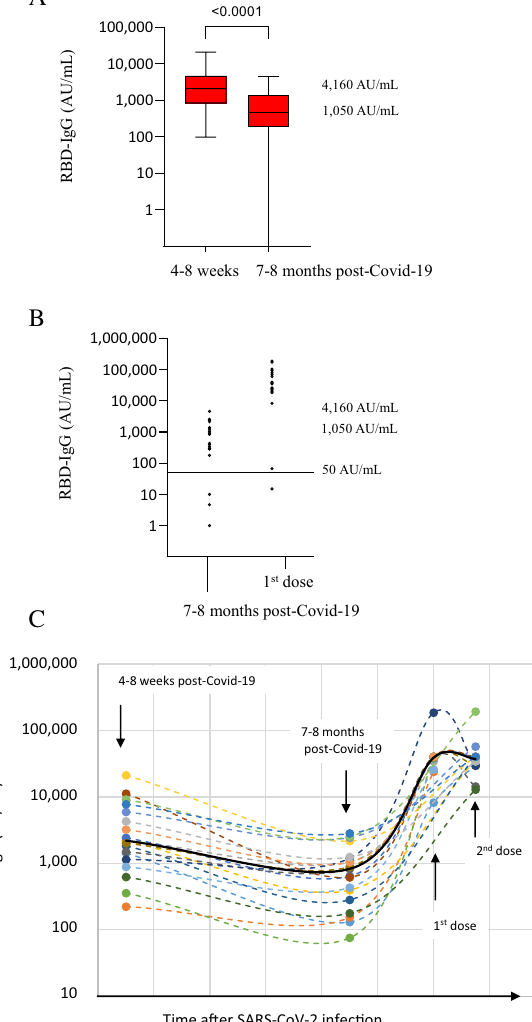
Figure 4. RBD-IgG levels after SARS-CoV-2 infection and relationship to vaccine response. ( A ) RBD-IgG level in response to natural immunization, 4–8 weeks (26 NH residents) and 7–8 months (n = 71 NH residents) after SARS-CoV-2 infection. ( B ) Individual changes in RBD-IgG levels after the first dose, in NH residents tested 7–8 months after SARS-CoV-2 infection. ( C ) Follow-up of RBD-IgG levels in NH residents tested after natural immunization and vaccination; black line indicates the mean RBD-IgG